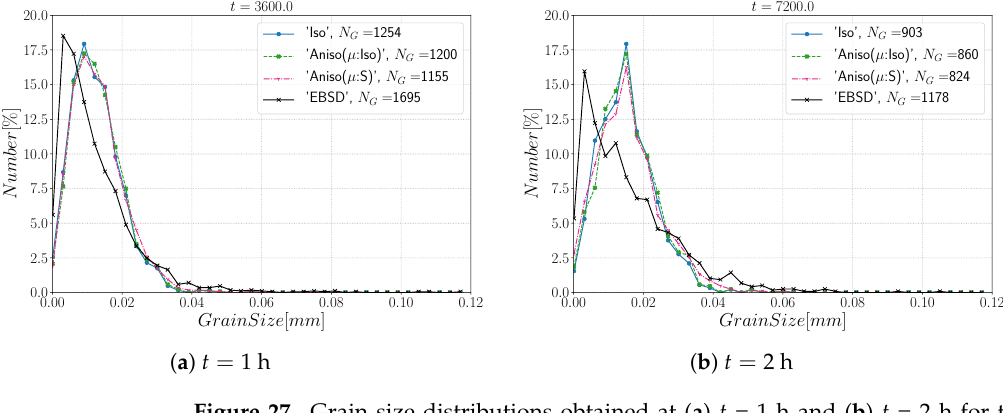
Figure 27. Grain size distributions obtained at ( a ) t = 1 h and ( b ) t = 2 h for the isotropic (Iso) formulation, anisotropic formulations with isotropic GB mobility (Aniso( µ :Iso)) and heterogeneous GB mobility (Aniso( µ :S)), and the experimental data (EBSD); N G refers to the number. Numerical results obtained from the initial immersed microstructure shown in Figure 25a and the GB5DOF code to define the GB energy.